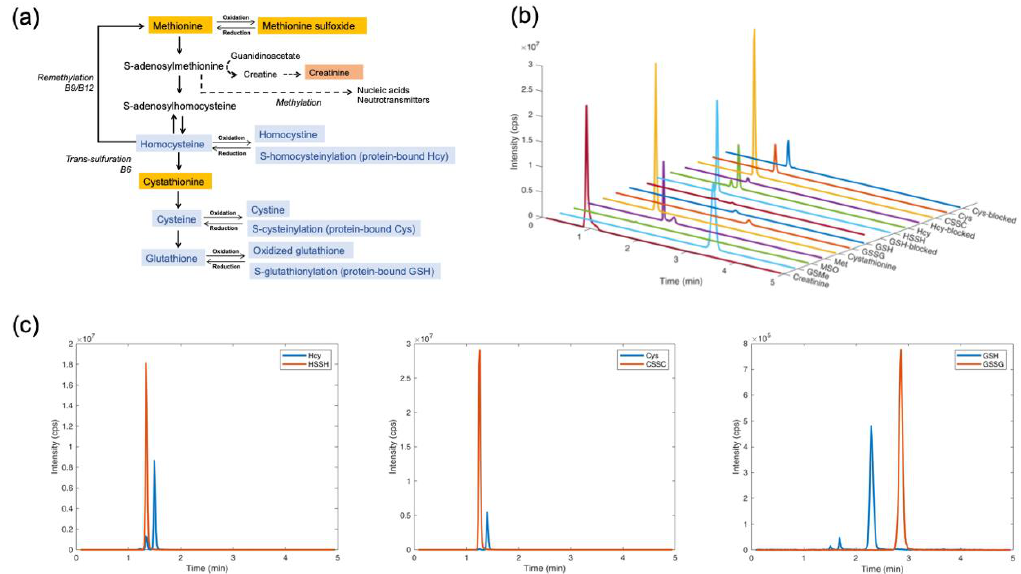
Figure 1. Pathways and chromatograms of the 10 metabolites examined in this study. Panel ( a ). Metabolites and redox species determined in this study are shown in colored boxes. Dietary Met is predominantly converted to S -adenosylmethionine (SAM), the universal methyl donor that furnishes nucleic acid and neurotransmitter metabolism. Guanidinoacetate, an intermediate of arginine metabolism, is methylated by SAM to form creatine-phosphate, the precursor of creatinine. Methyl transfer reactions driven by SAM yield S -adenosylhomocysteine (SAH), which is in turn converted to homocysteine. Depending on cellular needs, homocysteine can undergo remethylation to Met, conversion back to SAH or enter the transsulfuration pathway for the biosynthesis of cystathionine and cysteine, which represents the first half of the glutathione biosynthesis pathway. Cys, Hcy and GSH exist in free reduced and free oxidized forms, and also bound to proteins in the form of mixed disulfides. Reactions involved in the methionine cycle and transsulfuration routes utilize vitamins B6, B9 (folate) and B12 as cofactors. Deficiencies of these B-vitamins result in characteristic changes in metabolite concentrations, with the common denominator of homocysteine elevation. Panel ( b ). Chromatogram of thiol and thioether metabolites and creatinine. The terms Hcy-blocked, Cys-blocked and GSH-blocked denote the corresponding free-reduced species of homocysteine, cysteine and glutathione upon derivatization with iodoacetamide. Panel ( c ). Chromatogram of oxidized and reduced thiol species of Hcy, Cys and GSH. The metabolites were separated in a total running time of 5 min, using acidic conditions with solvent A 0.1% formic acid in water and solvent B 0.1% formic acid in methanol.